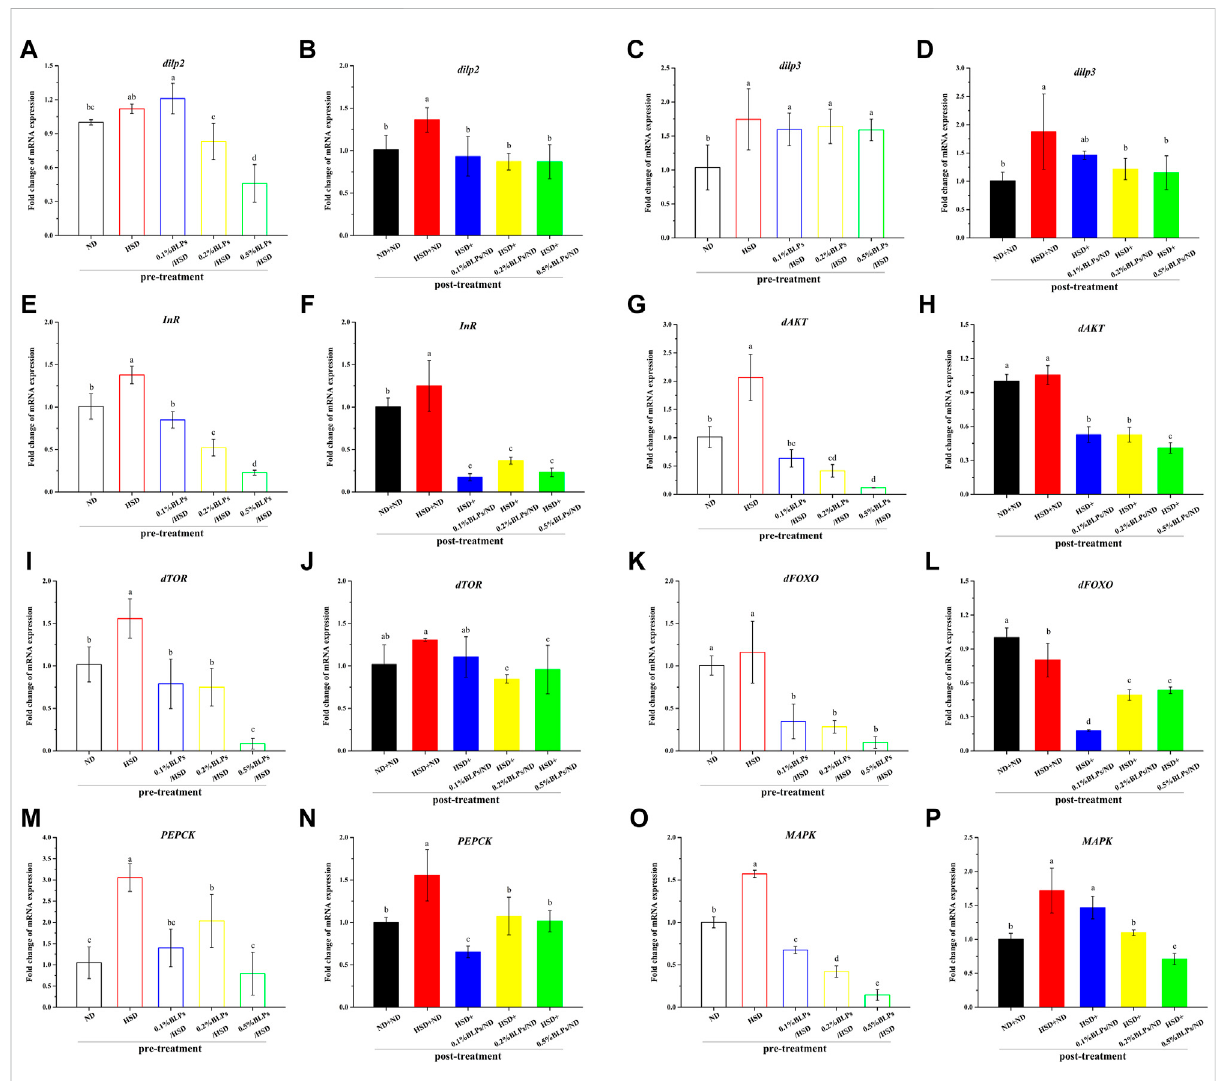
FIGURE 6 mRNA expression of main genes associated with glucose metabolism of those fl ies fed on media containing BLPs at different concentrations. Values with different letters (A – P) represent signi fi cant differences among the groups ( p <